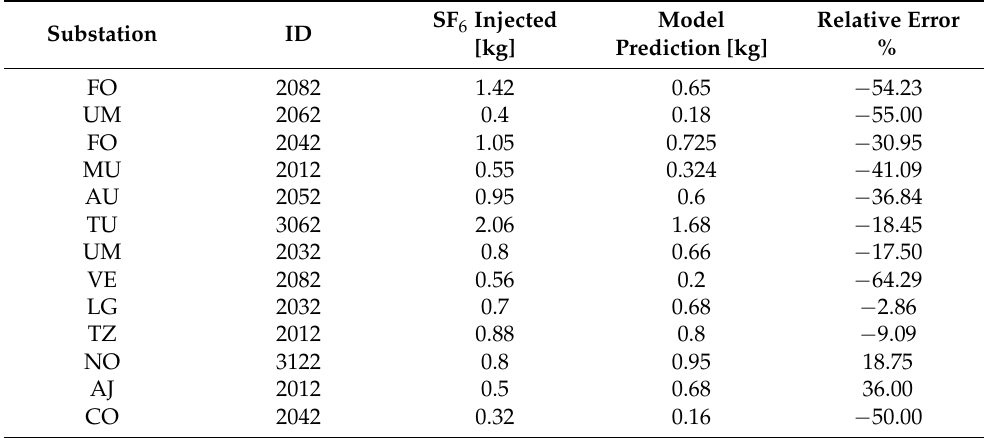
Table 4. Comparison of model results against historical